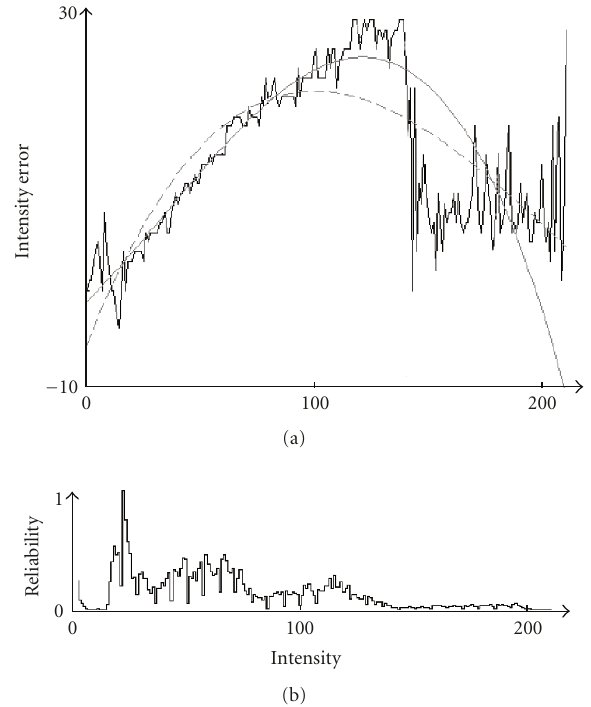
Figure 6: Measured and polynomial approximated (dashed:basic fitting - solid:weighted fitting) intensity error profiles as a function of intensity between the first two frames of test sequence Caption . A quadratic model is used. The histogram below shows the normalised confidence values r t ,ref for each